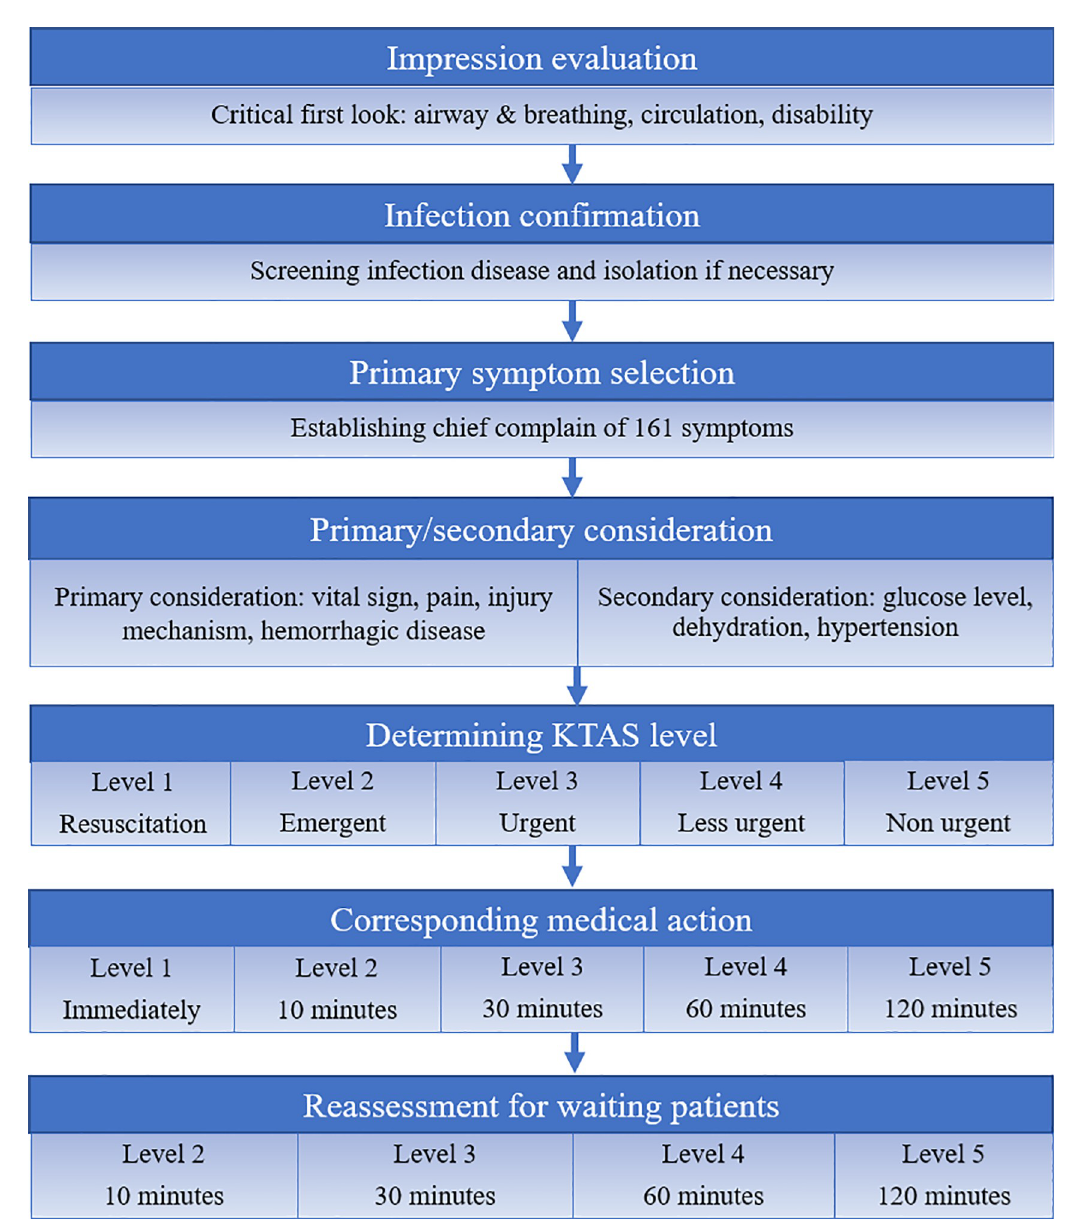
Fig 1. Process of the Korean Triage and Acuity